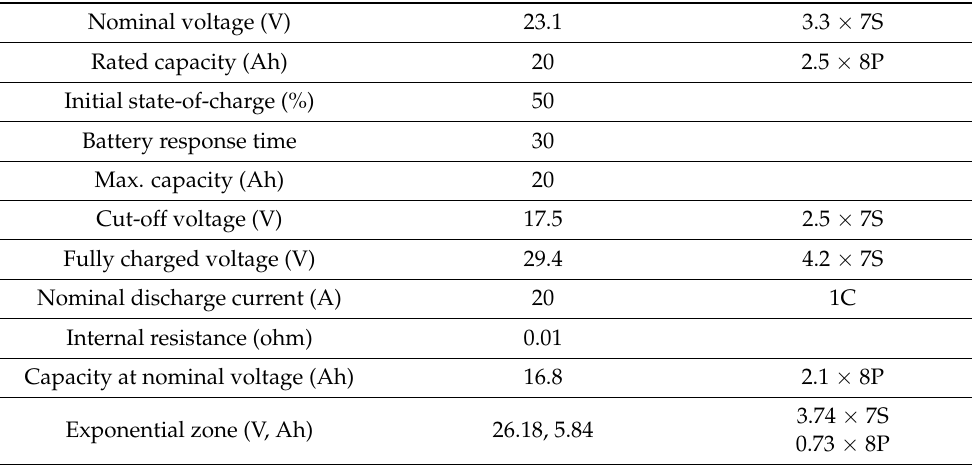
Table 5. Battery model parameters.